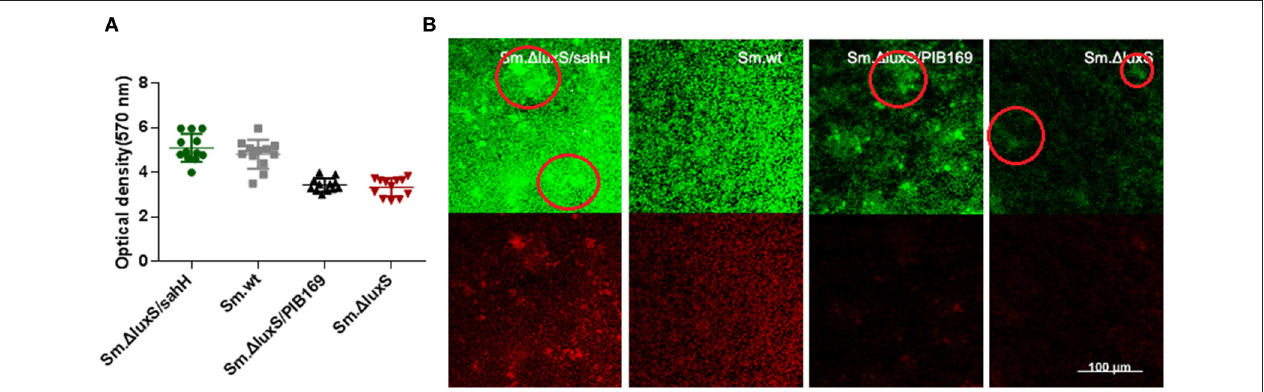
FIGURE 2 | Quantification of biofilms by CV staining and CLSM of biofilms formed by S. mutans and derivative strains. (A) Quantification of biofilms. Two independent experiments were performed ( n = 3 for each strain). The results are shown as mean ± SD , and the asterisks represent a significant difference ( P < 0.05) compared to the Sm. 1 luxS strain. (B) The CLSM of biofilms. Double-labeling imaging of bacteria (green) and EPS (red) of biofilm formed on the surface of glass coverslips, showing the topographic features of biofilm. Images are representative of compressed biofilms in strains Sm. wt, Sm. 1 luxS , Sm. 1 luxS / sahH, Sm. 1 luxS /pIB169. The distinct bulges which were resulting from high-density cell aggregates in Sm. 1 luxS / sahH , Sm. 1 luxS, and Sm. 1 luxS /pIB169 were circled. Images were randomly captured from each sample.